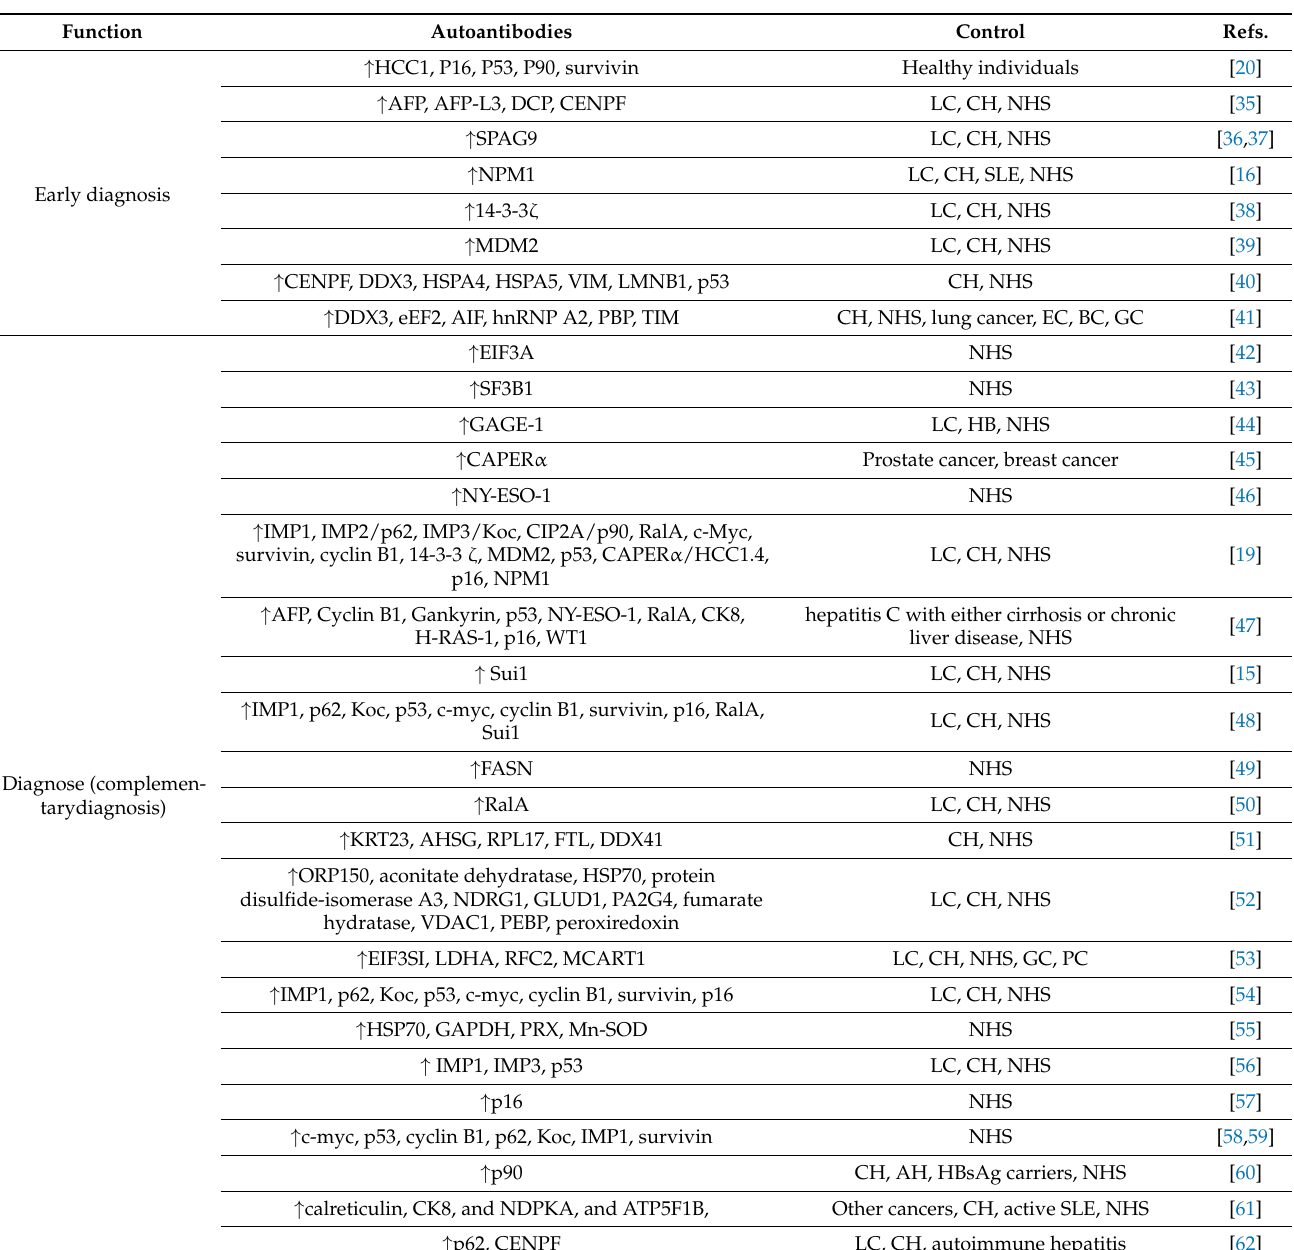
Table 1. TAA as biomarkers in